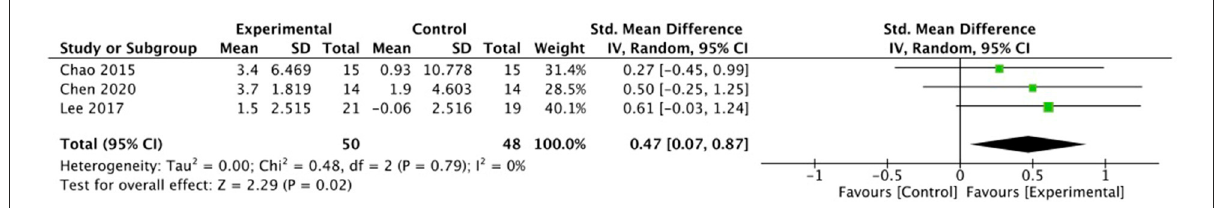
FIGURE5 Random effects meta-analysis forest plot for effectiveness of intervention on measures of BBS balance outcomes.